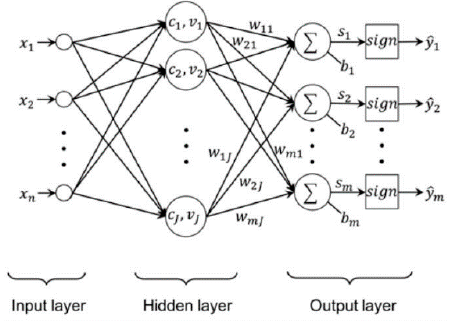
Figure 1. Architecture of the proposed network model.